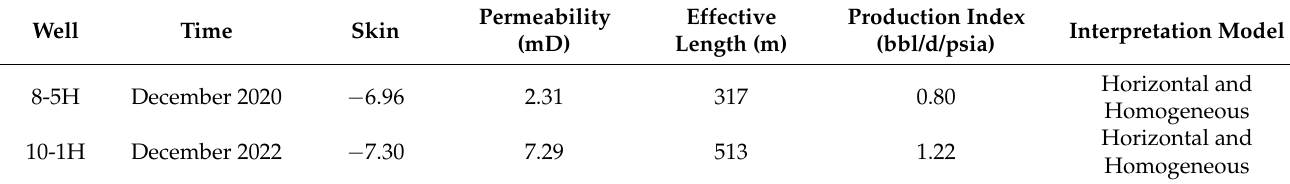
Table 4. Comparison table of well test parameters for production wells.